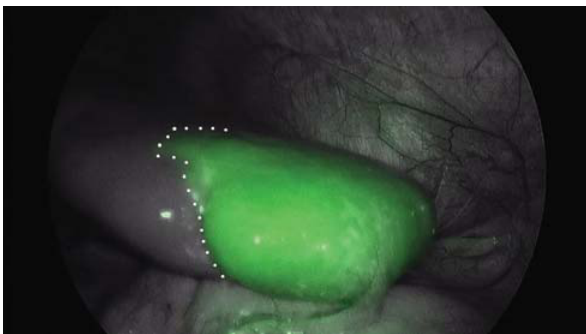
Fig. 5 Intraoperative image. Division of the lateral pole from the medial pole using Caiman